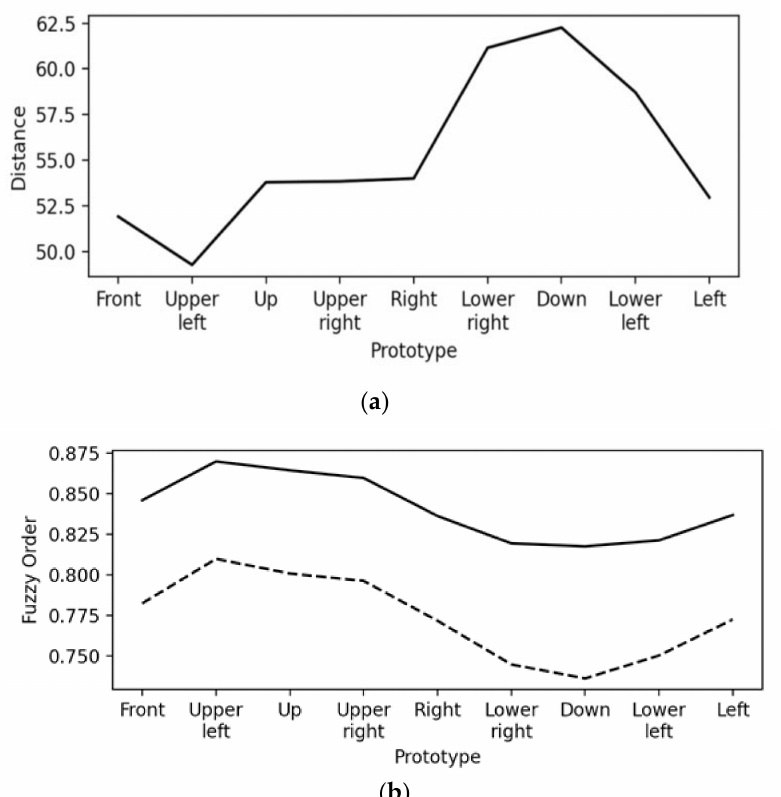
Figure 7. Two “measures of similarity” between an arbitrary testing frame of the class ‘Upper Left’ head orientation for 40 cm/normal environmental conditions versus nine head orientations (classes) prototypes regarding ( a ) the metric distance function Equation (2), and ( b ) the fuzzy order functions Equations (3) and (4), where the solid line corresponds to Equation (3) (i.e., σ (cid:116) ), whereas the dashed line corresponds to Equation (4) (i.e., σ (cid:117) ).